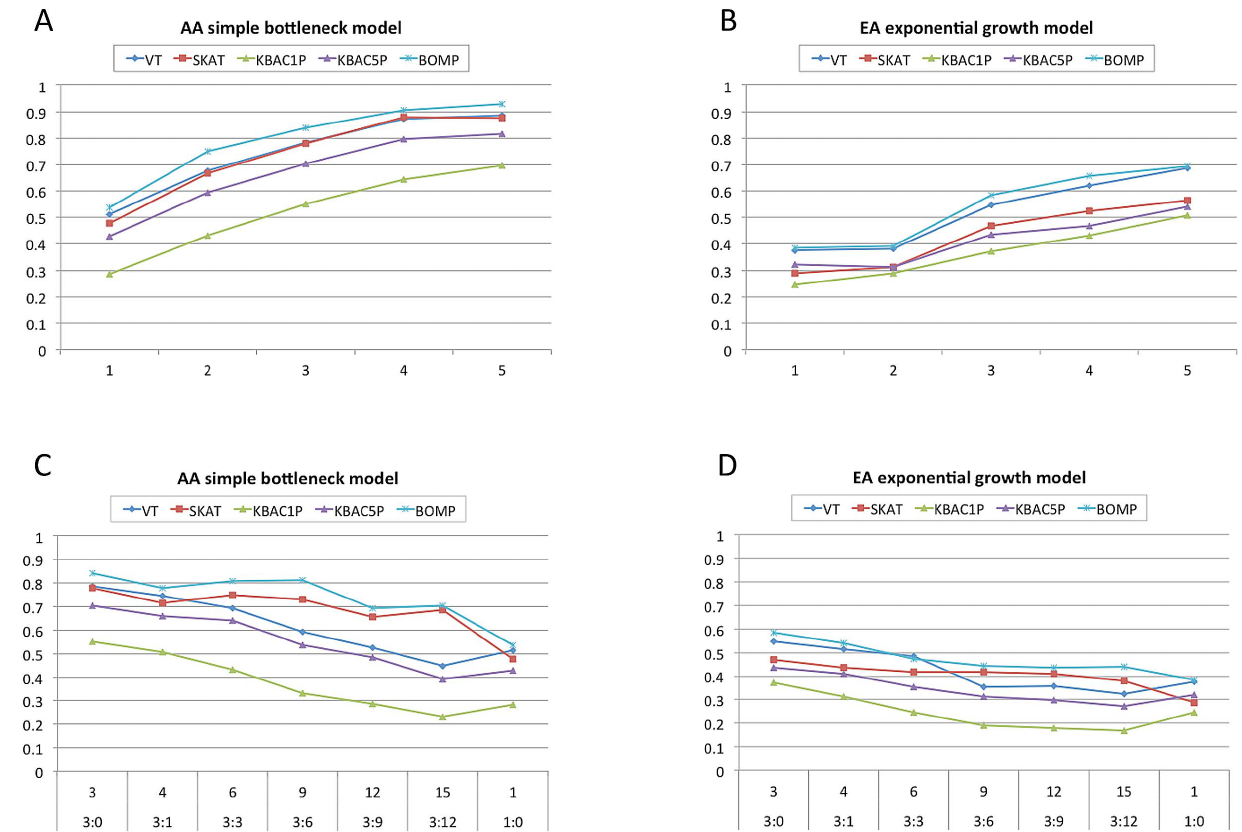
Figure 2. Power estimates for multiple gene case-control studies with causal variants equally likely to be from any disease etiology dominated by rare variants. A,B. X-axis shows number of candidate genes in 250 simulated case-control studies (approximately one-third each from disease etiologies Rare, LowFreq and KeyRegion). All genes contain causal variants. For each method, average power is shown. Power increases for all methods as the number of candidate genes with causal variants increases. C,D. X-axis shows the number of candidate genes and the ratio of genes containing causal variants to those that do not contain causal variants. As the ratio decreases, the power of the tested methods also decreases. (Tested methods are BOMP, VT, SKAT and KBAC1P=minor allele frequency defined as v 1% , KBAC5P=minor allele frequency defined as v 5% ). AA=the case-control studies were drawn from gene populations generated with an African-American simple bottleneck demographic model. EA=the case-control studies were drawn from gene populations generated with a European-American exponential growth demographic model.)